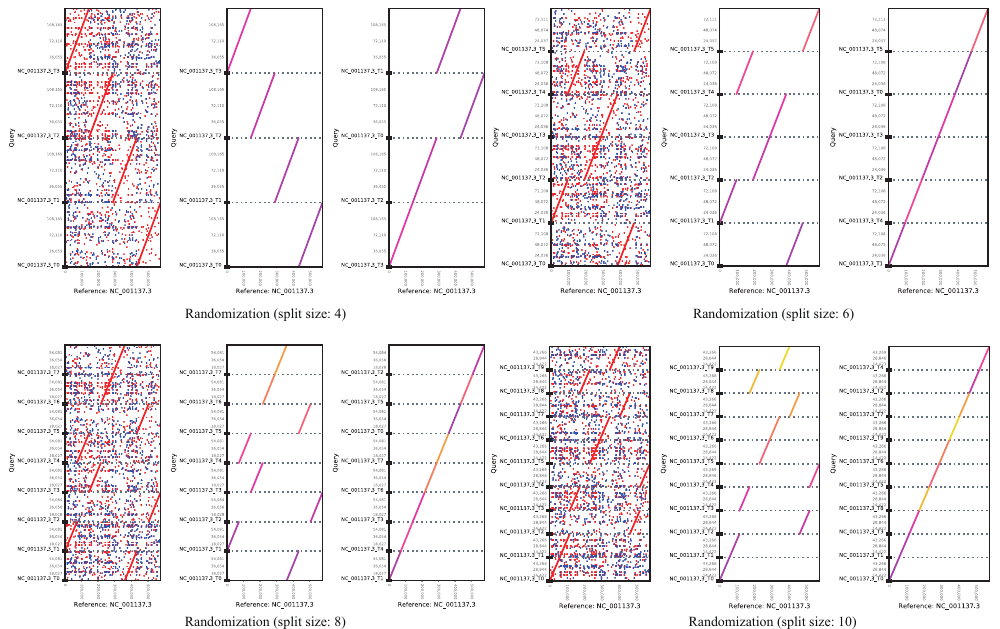
Figure 2. Comparative visualized analysis of short-read alignments with a split size. Table 2. Similarity of read alignments per divided